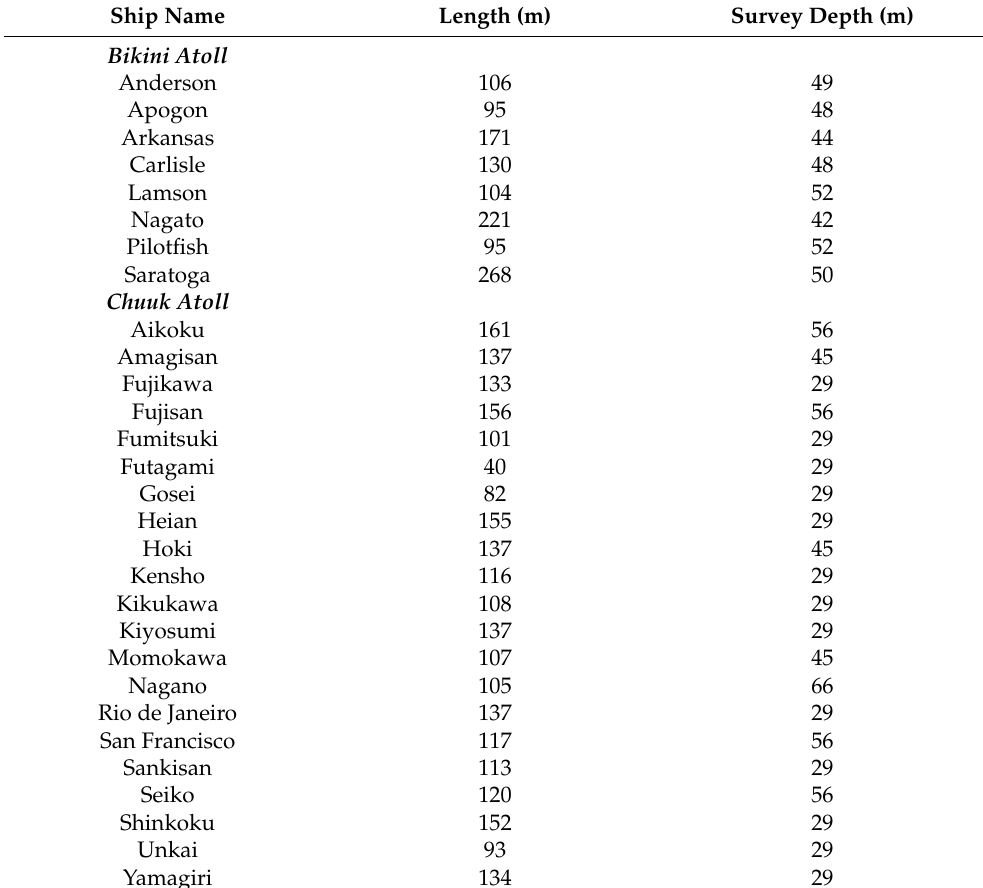
Table 1. Shipwrecks surveyed for coral diversity in Bikini and Chuuk